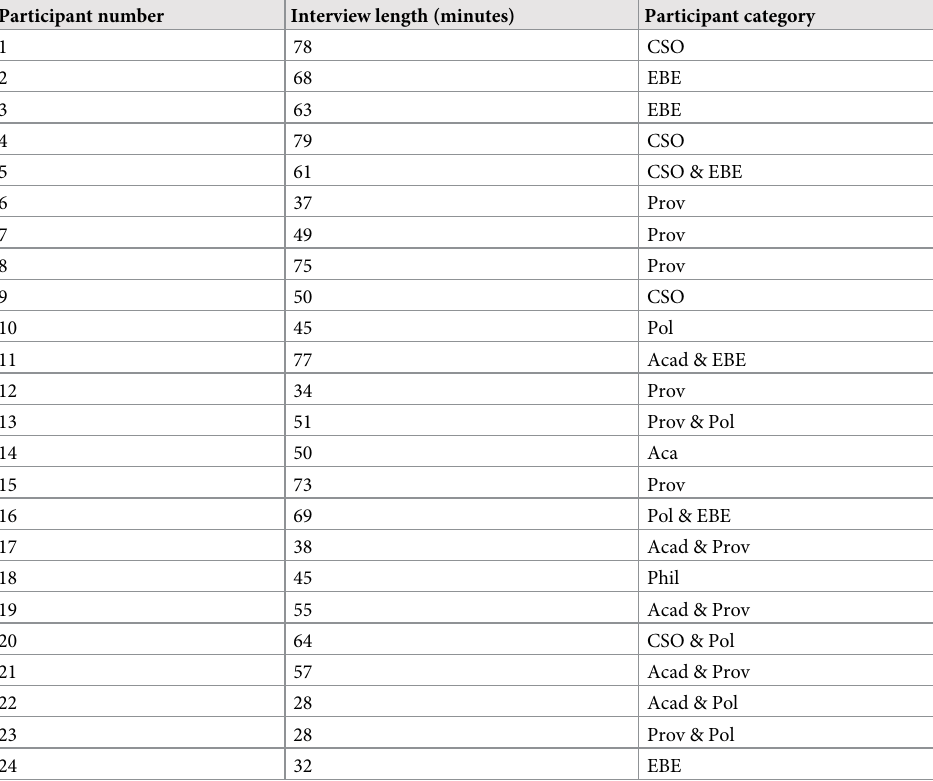
Table 1. Details of participant